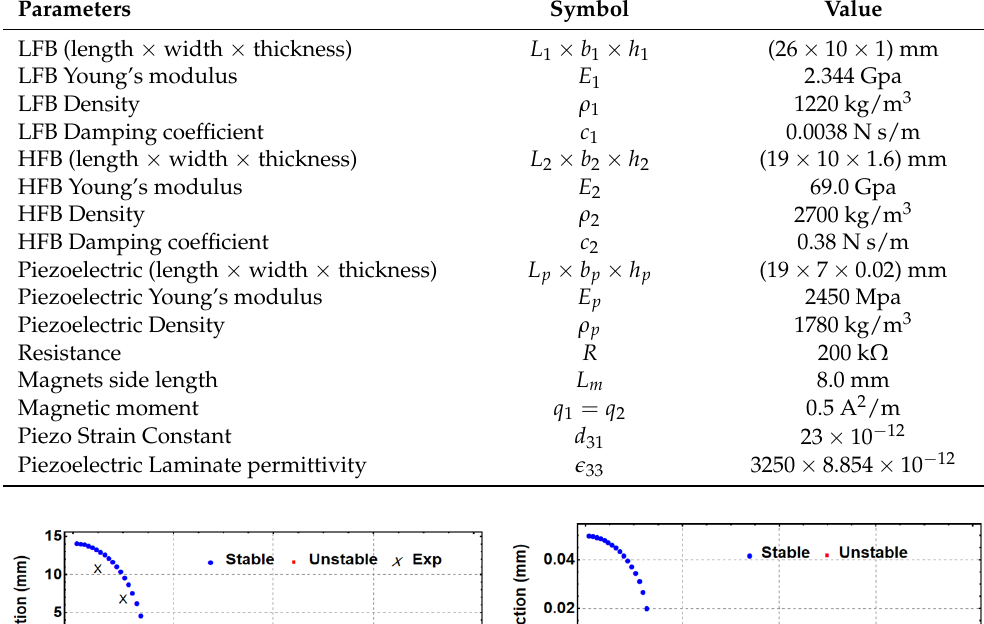
Table 1. Physical and geometrical parameters of the frequency up-converter piezoelectric energy harvester.